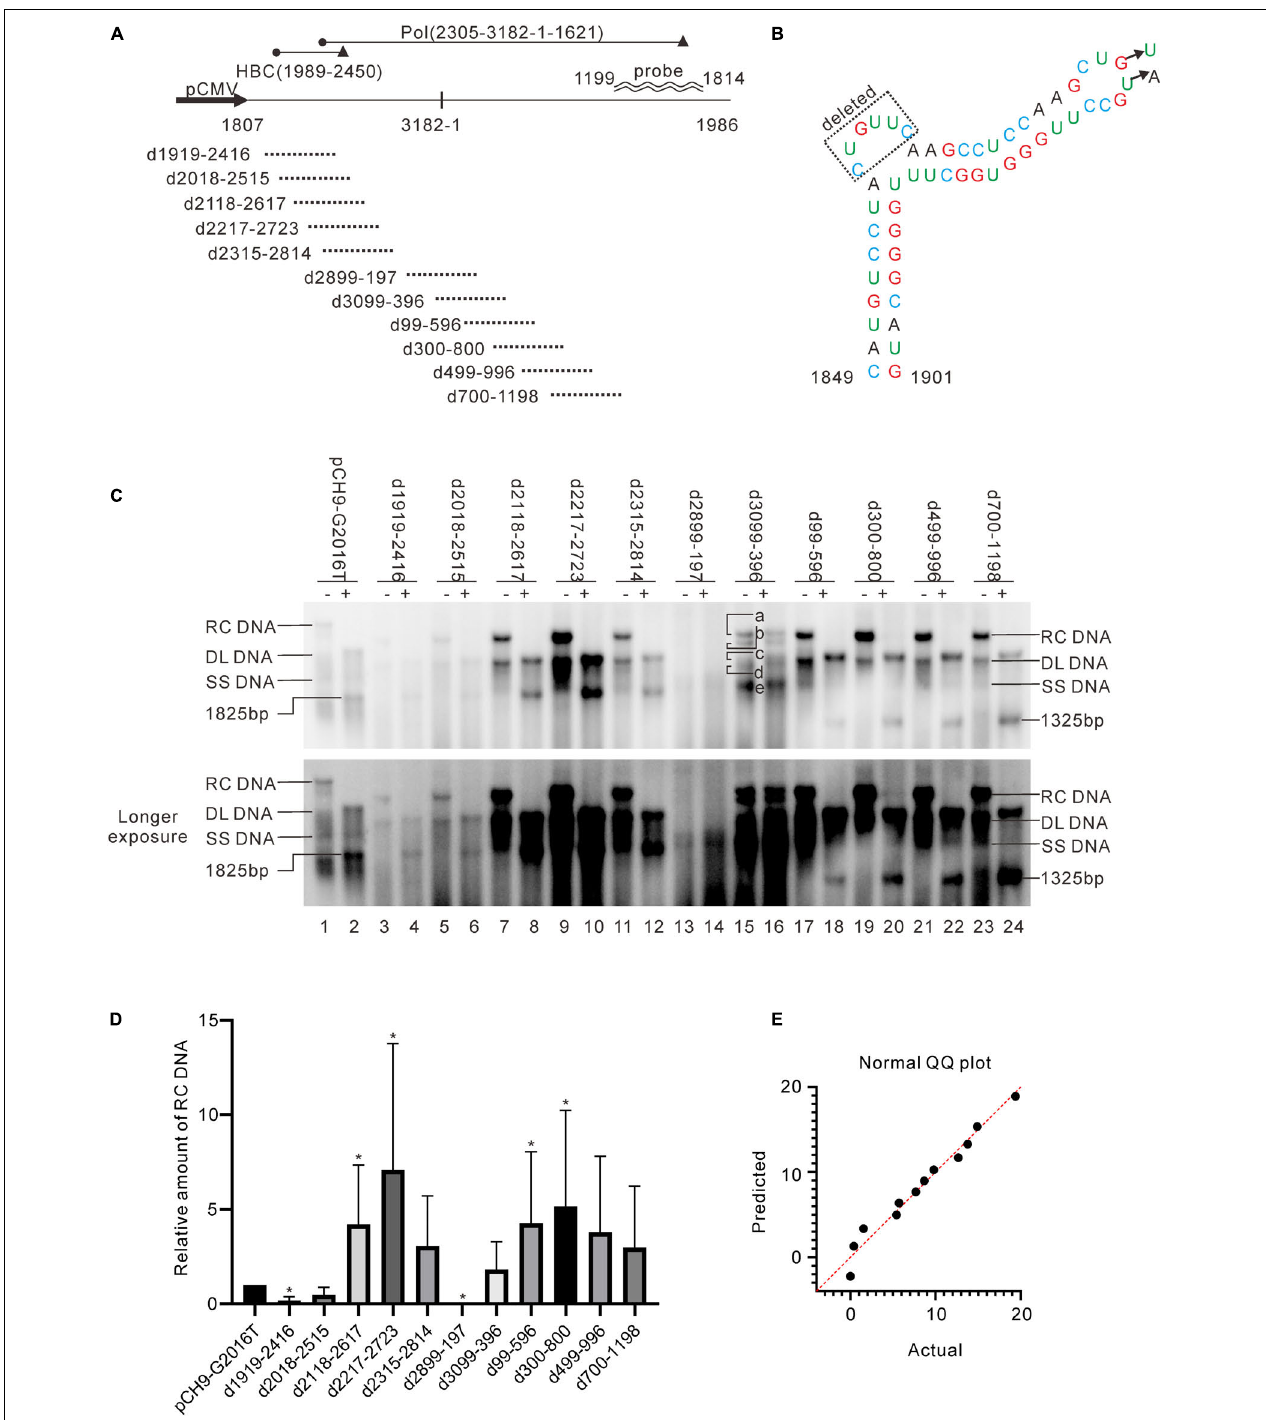
FIGURE 2 | Identification of two regions suitable for engineering. (A) Sequences that were deleted in different constructs. Deletion variants were named according to the sequences deleted. The black cycle and black triangle represent the start codon and the stop codon, respectively. The hybridization probe is shown (1199–1814). (B) The mutations of pCH9- (cid:49) ε . Sequence from 1858 to 1863 was deleted, and two additional mutations, G1877T and T1878A, were introduced. (C) Representative Southern blotting of the deletion variants. The plus sign (+) denotes Eco RI digestion. RC, DL, SS DNA, and Eco RI digested fragments are indicated, respectively. (D) The relative intensity of RC DNA of deletion variants. The intensity of RC DNA of each sample was divided into the sum of RC DNA of all samples in the same membrane, respectively, to calculate the relative amount of RC DNA. N = 5. Asterisks (*) denote the difference between a deletion variant and pCH9-G2016T is statistically significant ( p < 0.05). (E) Normal QQ plot of the relative amount of the RC DNAs.